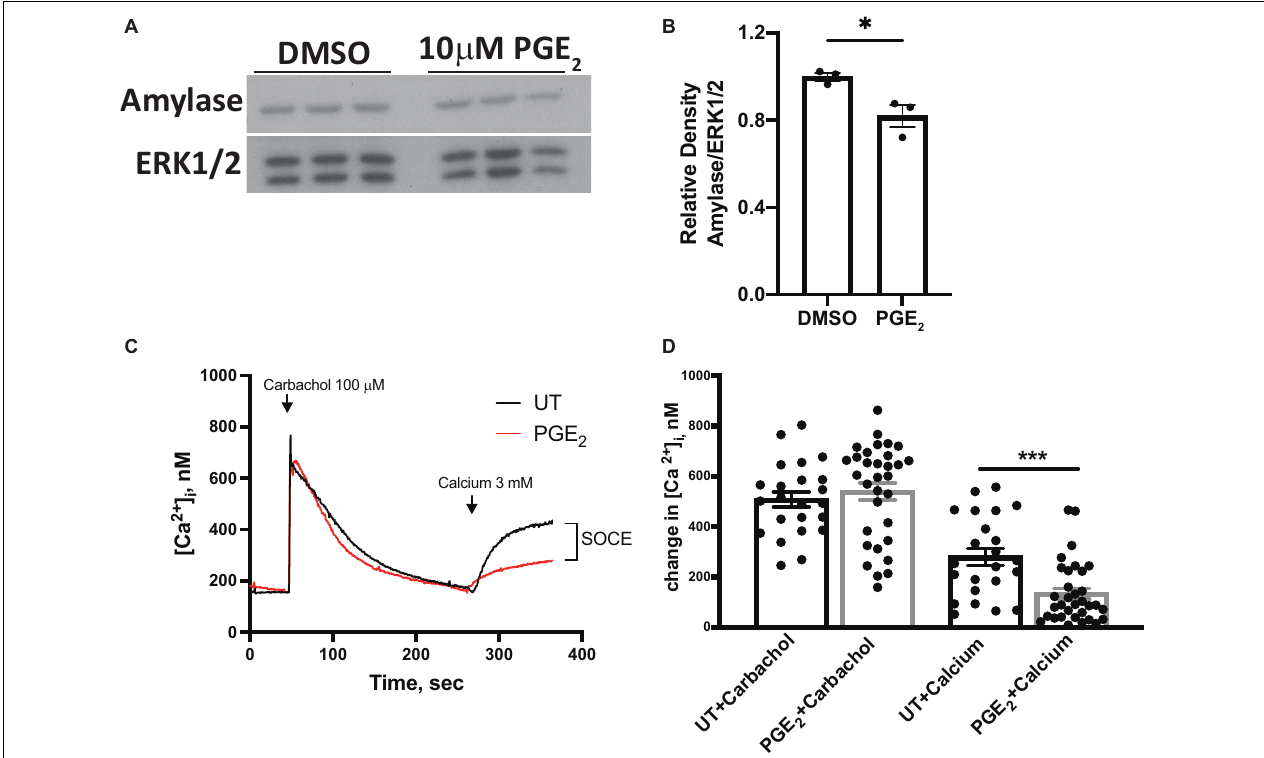
FIGURE 5 | PGE 2 treatment decreases amylase levels and store-operated calcium entry (SOCE) in primary parotid acinar cells. Primary parotid acinar cells were prepared from C57BL/6J mice as described in section “Materials and Methods.” (A–D) Primary parotid gland cells were untreated (UT) or treated with vehicle (DMSO) or PGE 2 (10 µ M) for 24 h. (A) Representative Western blot images of changes in amylase levels following PGE 2 treatment. (B) Densitometry of Western blots represented in panel (A) . (A,B) Immunoblots were prepared from cell lysates with an anti-amylase antibody which were stripped and re-probed for ERK1/2 as a loading control. Densitometry was done using ImageJ software and protein content was normalized to the average of DMSO-treated cells. Graphs represent the mean ± SEM. Each closed circle represents an independent sample. Significant differences from DMSO-treated cells were determined via a student’s t -test (* p < 0.05). (C) Representative tracings of time-dependent fura-2 fluorescence in mouse primary parotid acinar cells pretreated with or without PGE 2 (10 µ M) for 24 h, stimulated with carbachol (100 µ M) in calcium-free media followed by addition of calcium (3 mM) where indicated. (D) Peak changes in [Ca 2 + ] i induced by carbachol and the indicated addition of 3 mM calcium. Values are mean ± SEM of results from 23 to 33 cells from two separate cell preparations as shown with closed circles. Significant differences from untreated cells were determined via a student’s t -test (*** p <